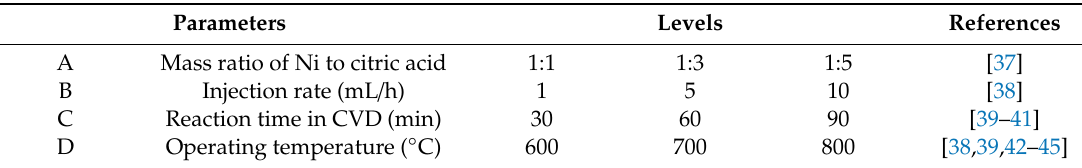
Table 5. Parameters and their levels.